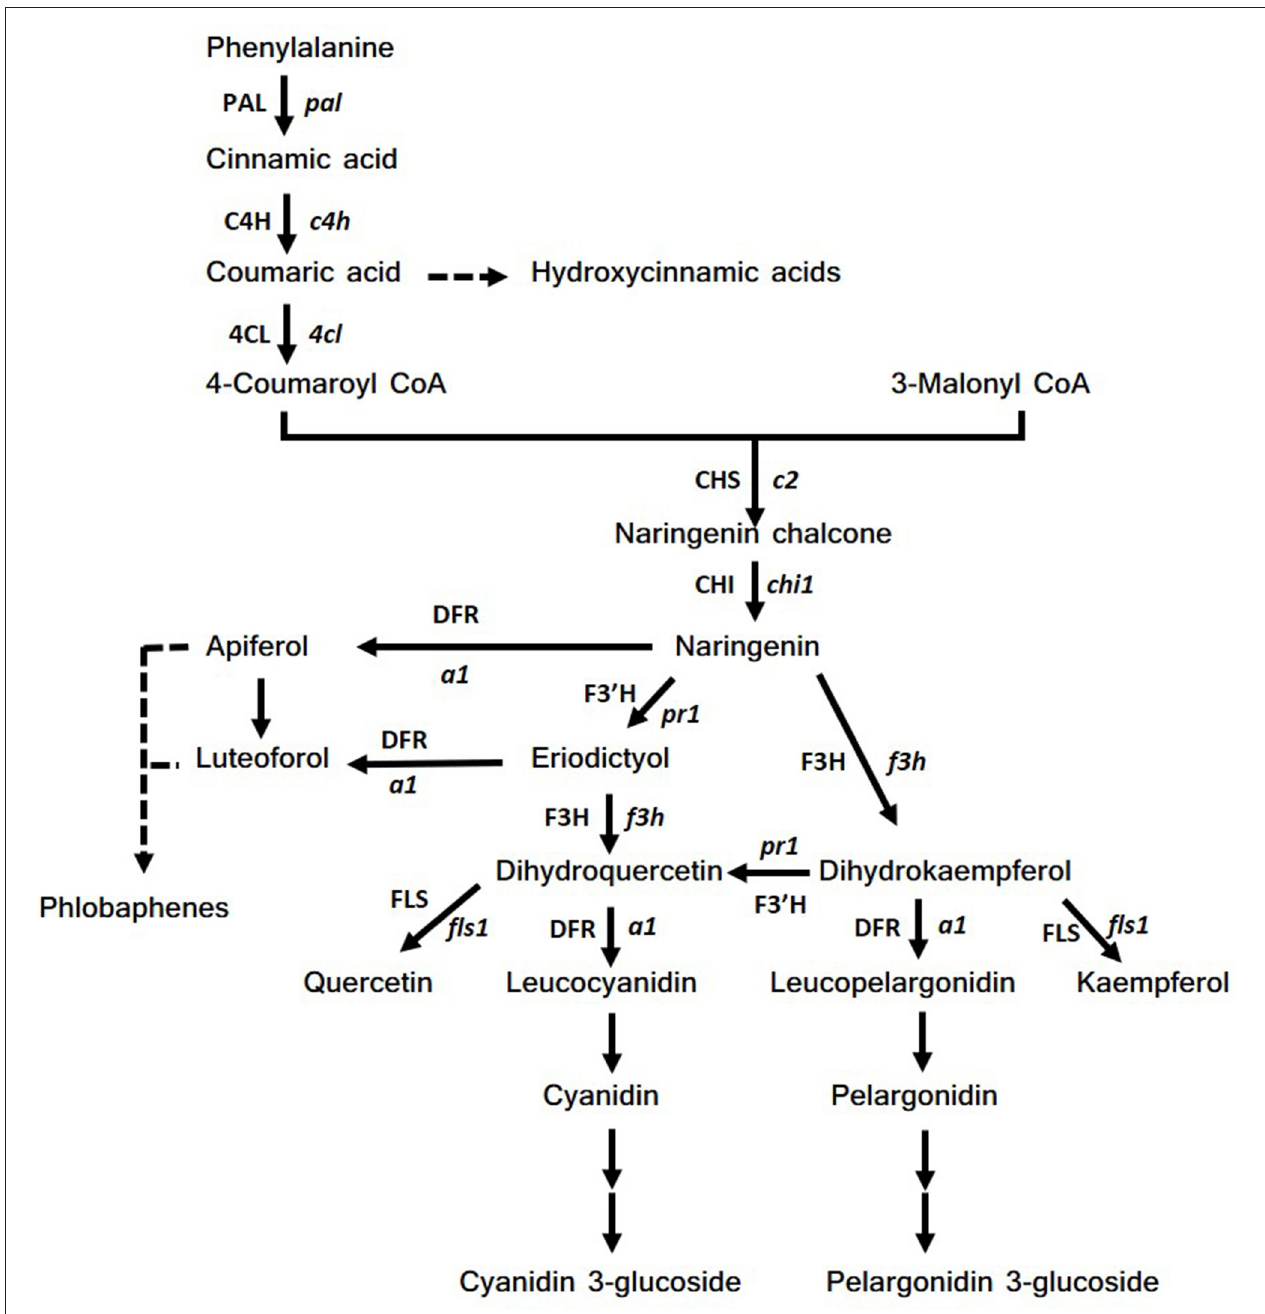
FIGURE 2 | Scheme of flavonoids biosynthetic pathway. Abbreviations of genes (enzymes): pal (PAL), phenylalanine ammonia lyase; c4h (C4H), cinnamic acid 4-hydroxylase; 4cl (4CL), 4-coumarate-CoA ligase; c2 (CHS), chalcone synthase; chi1 (CHI), chalcone isomerase; f3h (F3H), flavanone 3 hydroxylase; pr1 (F3 ′ H), flavonone 3’-hydroxylase; a1 (DFR), dihydroflavonol synthase. kidneys, and heart (79). Like other flavonoids, naringenin was